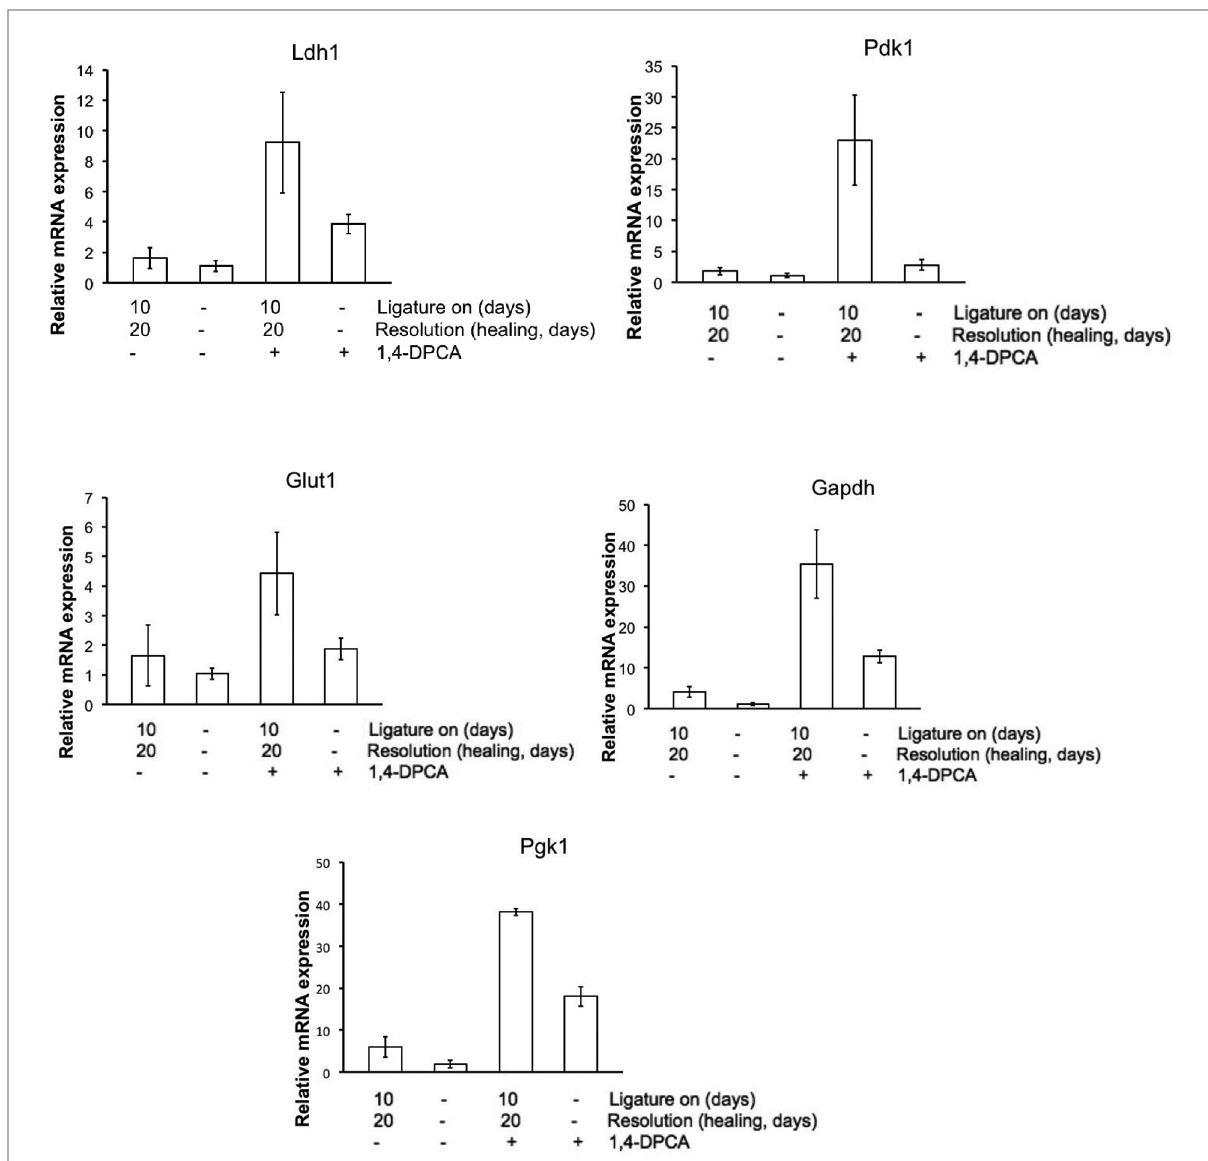
FIGURE 6 Metabolic gene expression in jaw tissue. In fi gure, mRNA was extracted from 2 sets of jaw tissue as seen in Figure 2 . QPCR was carried out and results show that for all metabolic genes associated with aerobic glycolysis, high expression levels were seen in tissue from mice treated with both 1,4-DPCA and with ligature placed round the 2nd molar. These results were done in triplicate ( n =3). The p -value differences between ligature with DPCA (3rd bar) and without DPCA (1st bar) were for LDHa, p =0.0439*; Pdk1, p =0.0095**; Glut1, p =0.0922 !; Gapdh, p =0.0103*; and Pgk1, p =0.0001**. These values were (a) highly suggestive (!), (b) signi fi cant (*), and (c) highly signi fi cant